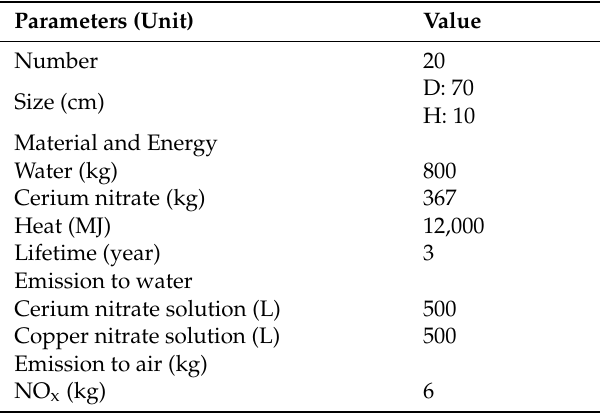
Table 5. Material and energy employed for catalysts production.